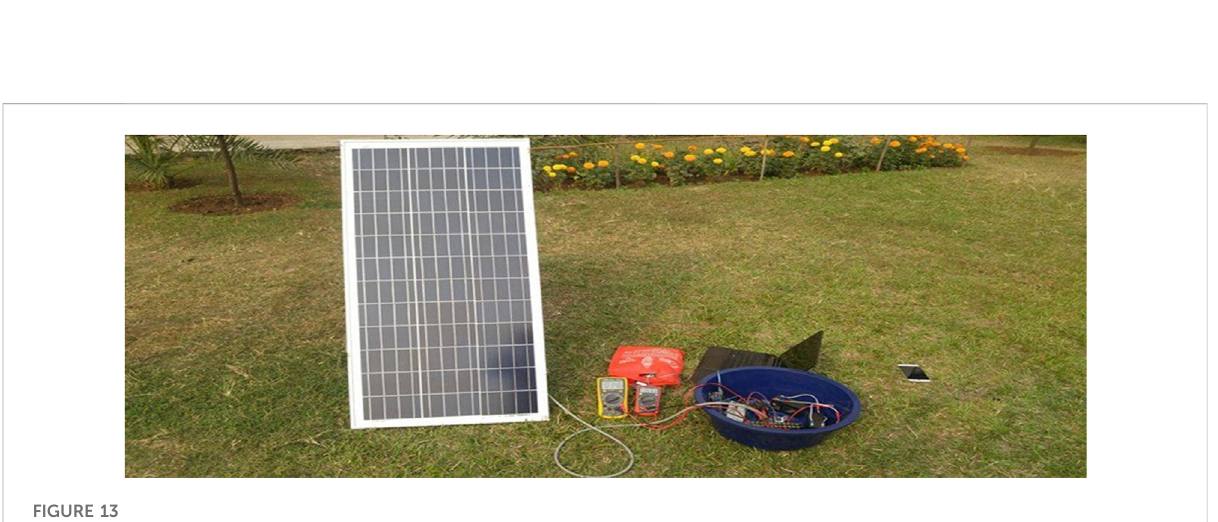
FIGURE 13 Full hardware